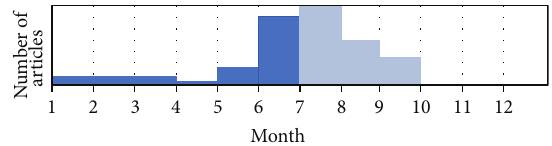
Figure 2: The number of articles in the year of 2009.